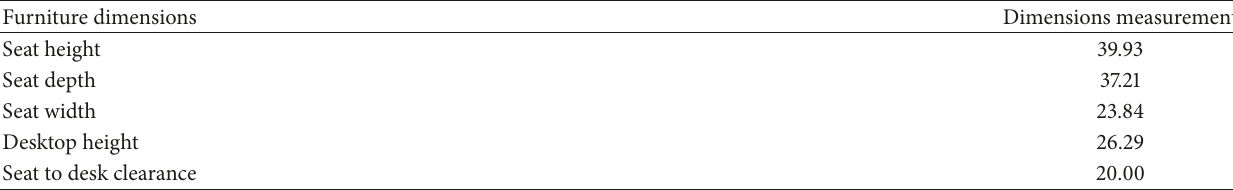
Table 2: Dimensions (cm) of existing classroom furniture.